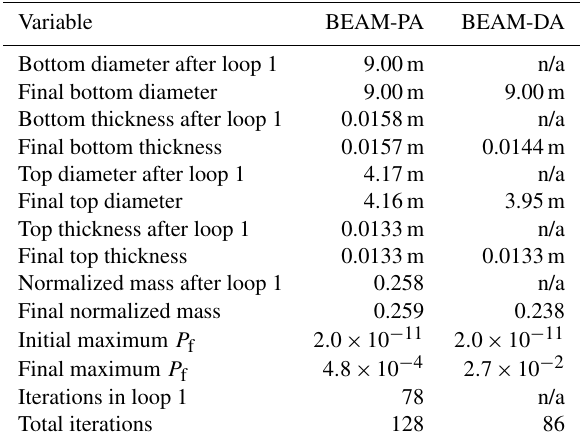
Table 6. Selected summary results of cases BEAM-PA and BEAM-